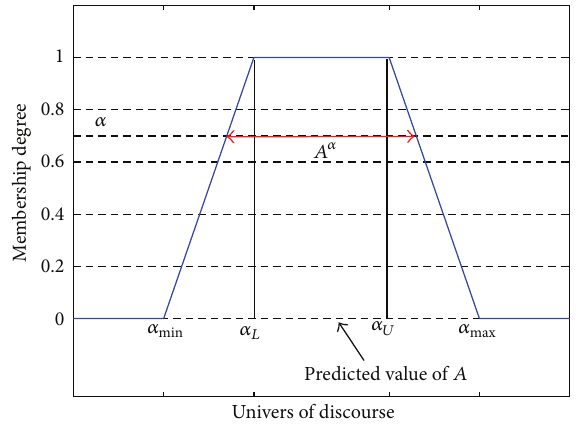
Figure 1: Fuzzy trapezoidal